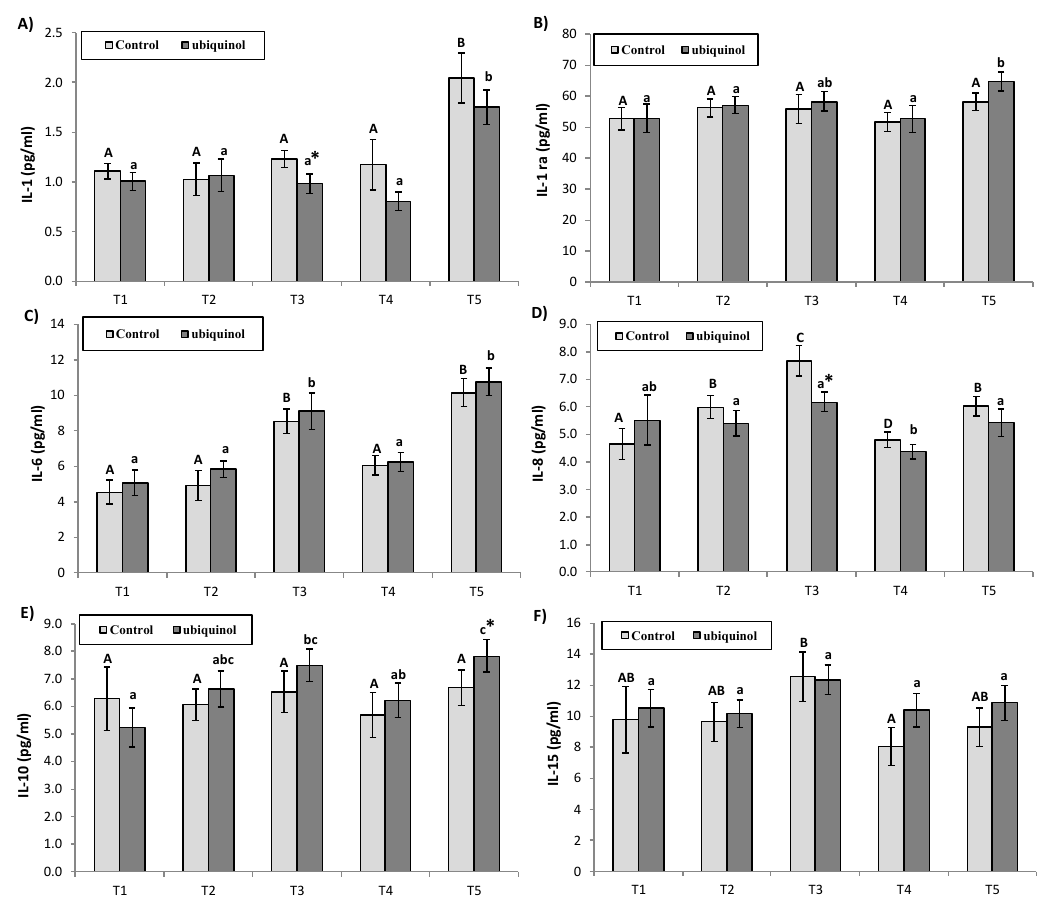
Figure 1. E ff ects of exercise and ubiquinol supplementation on plasma cytokines: interleukin (IL)-1 ( A ), IL-1ra ( B ), IL-6 ( C ), IL-8 ( D ), IL-10 ( E ), IL-15 ( F ). Results are expressed as the mean ± SEM. *